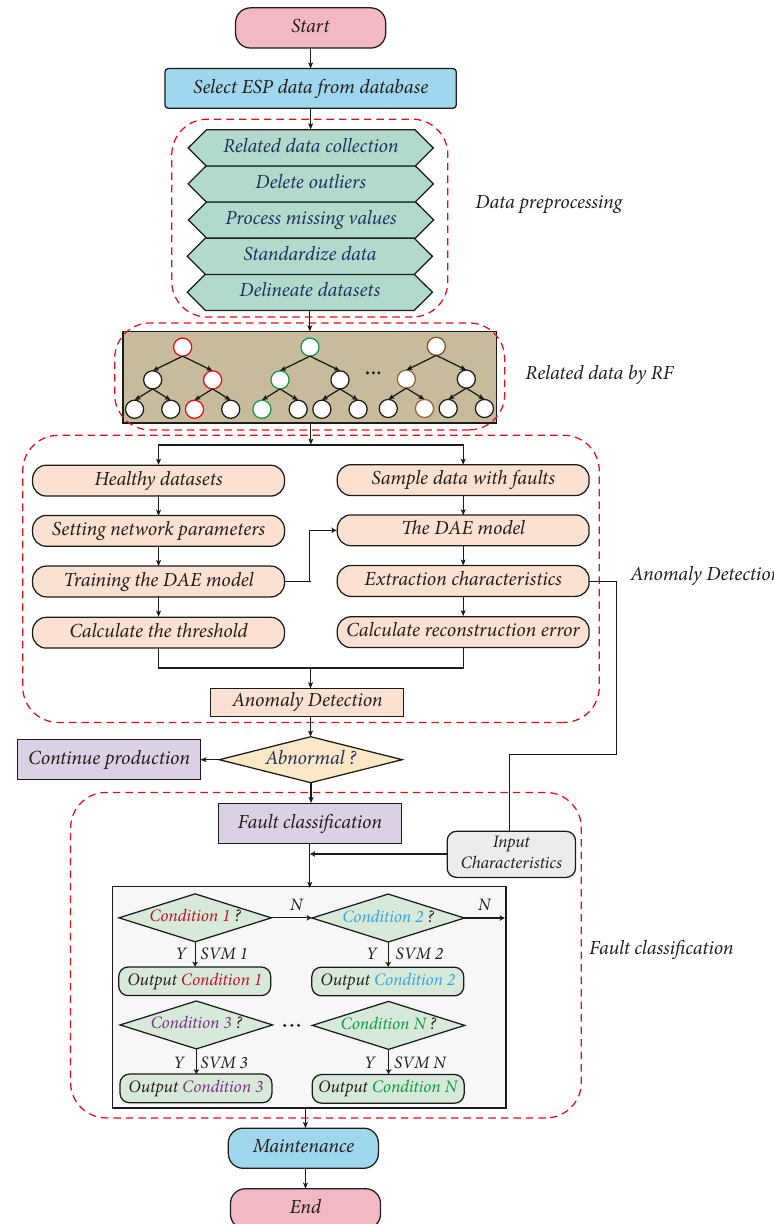
Figure 6: ESP abnormal detection and fault diagnosis flow